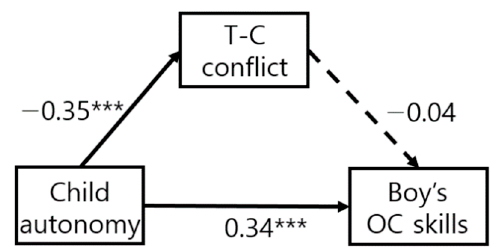
Figure 2. Object control skills of boys. *** p < 0.001.